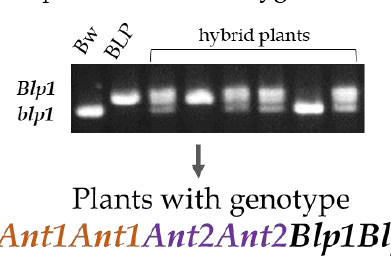
Figure 1. The strategy for marker-assisted selection of the barley NIL carrying dominant alleles of genes Ant1 , Ant2 , and Blp1 in the Bowman genetic background. NILs i:Bw Ant1Ant2 and i:Bw Blp1 , characterized by purple and black pigmentation of the grain, served as donors of the dominant alleles of Ant1 , Ant2 , and Blp1 , respectively. The three-step selection of homozygous F 3 plants for the target genes was carried out on the basis of leaf sheath pigmentation assessment (1), donorlike homozygous diagnostic markers of genes Ant1 and Ant2 (2), and an SSR-marker linked with the Blp1 gene (3). The selected plants homozygous for the target genes were propagated and checked for phenotype stability in generations F 4–5 . One plant from a group devoid of segregation of the pigmentation traits was selected as NIL i:Bw Ant1Ant2Blp1 .